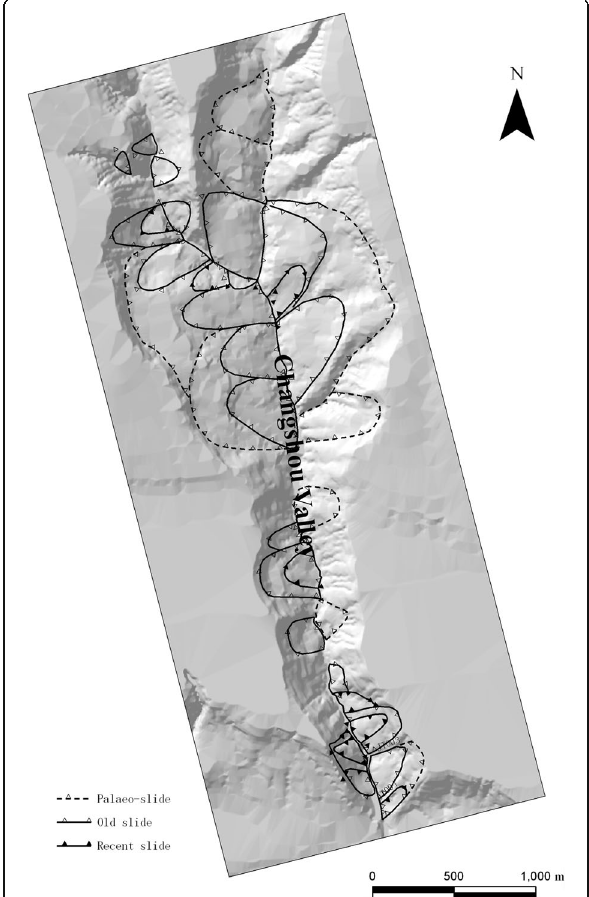
Fig. 2 Landslide inventory mapping in the Changshougou